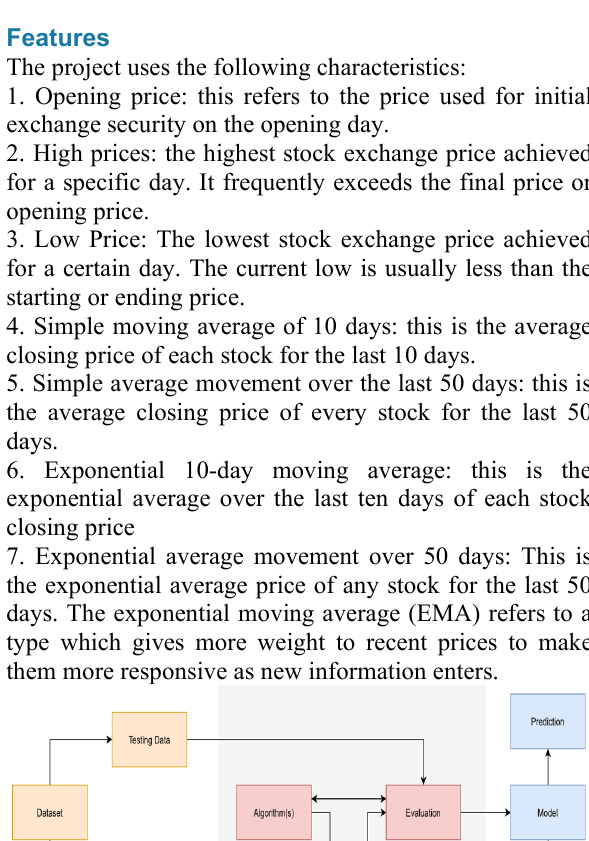
Performance metrics i.e. RMSE and Mean Squared